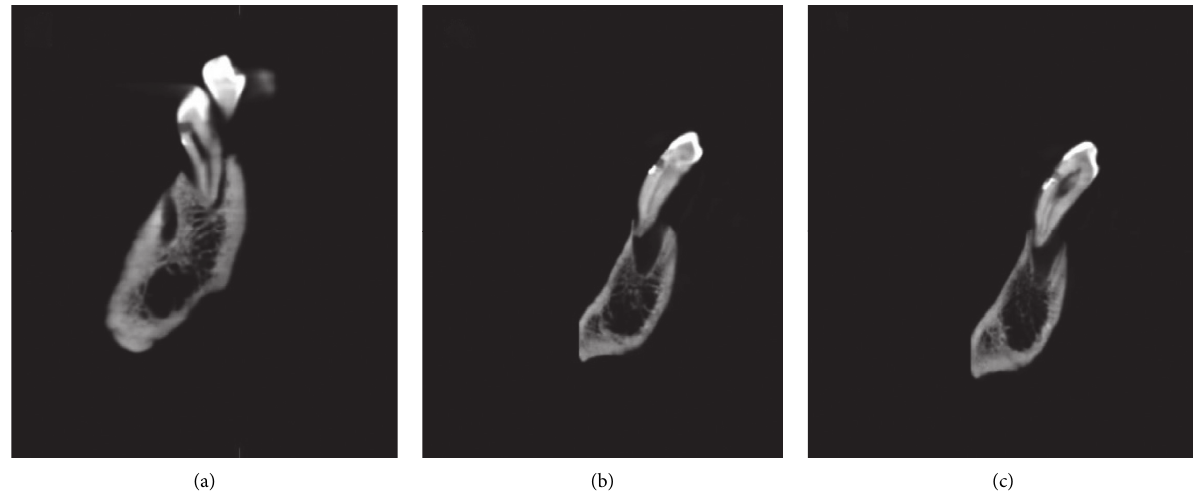
Figure 3: Marginal leakage on the gingival wall detected by the Planmeca CBCT unit (Planmeca ProMax 3D Mid machine, Helsinki, Finland). (a) Score 0. (b) Score 1. (c) Score